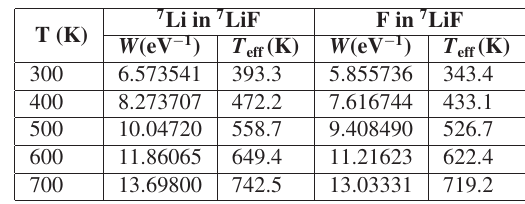
Figure 4. The thermal neutron scattering cross sections of 7 LiF at 300K. Table 2. Effective Temperatures and Debye- Waller integrals divided by the atomic mass for 7 LiF